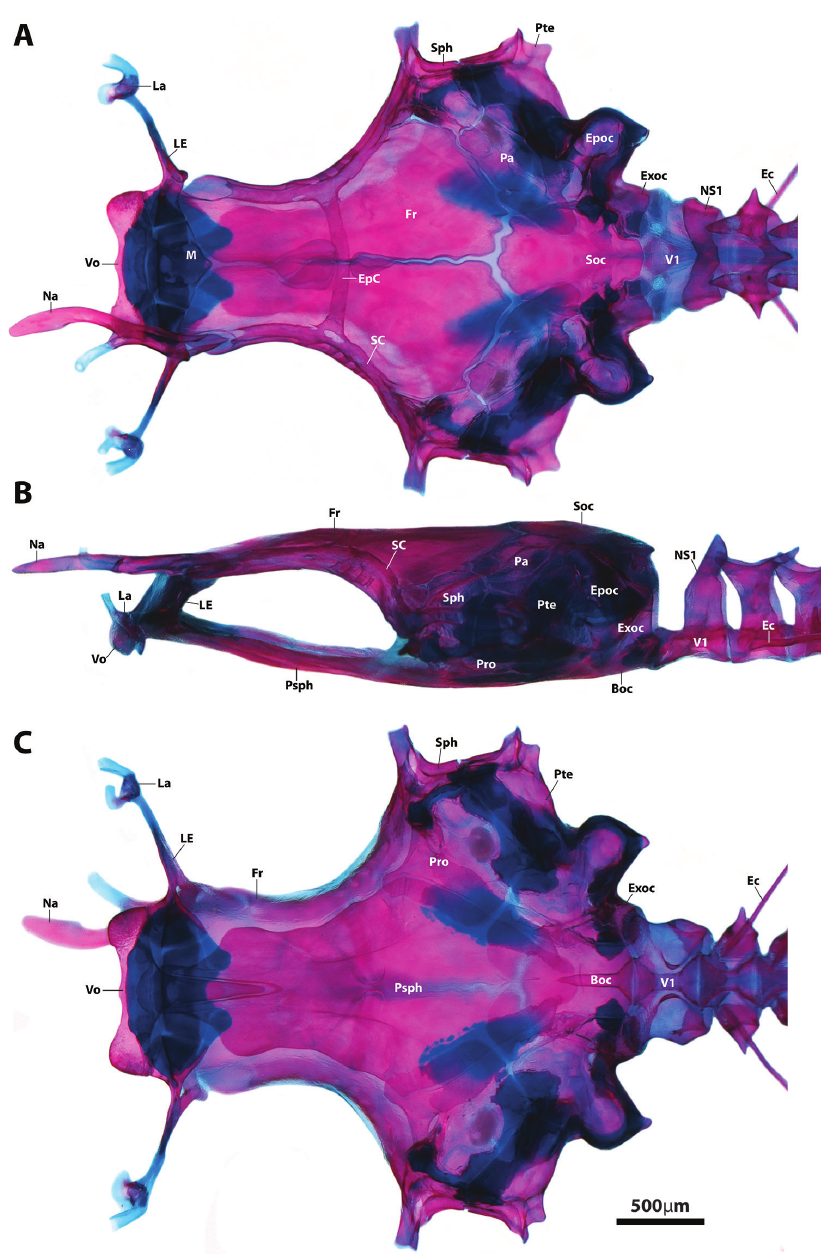
Figure 6. Neurocranium of Flexor incus , AIM MA655142, paratype, 20.0 mm SL. A Dorsal view B Lateral view (left side) C Ventral view. Abbreviations: Boc, basioccipital; Ec, epicentral; EpC, epiphyseal commissure of supraorbital canal; Epoc, epiotic; Exoc, exoccipital; Fr, frontal; La, lachrymal; LE, lateral ethmoid; M, me- sethmoid; Na, nasal; NS1, neural spine of vertebral centrum 1; Pa, parietal; Pro, prootic; Psph, parasphenoid; Pte, pterotic; SC, supraorbital canal; Soc, supraoccipital; Sph, sphenotic; V1, vertebral centrum 1; Vo,